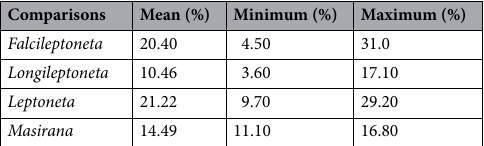
Table 2. K2P genetic distances between species within each